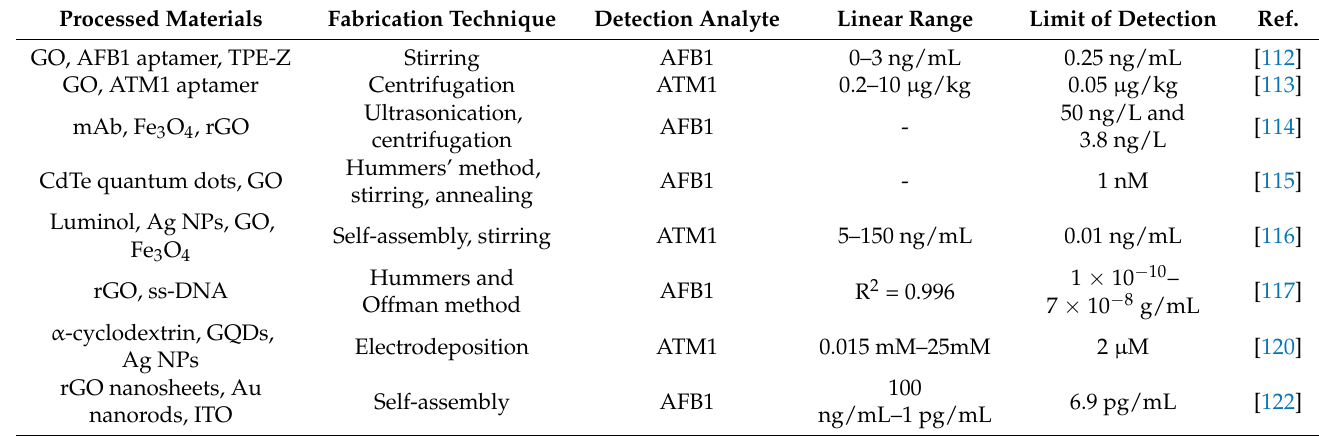
Table 4. Comparative study of the performances of the graphene-based sensors for the detection of ATM1 and AFB1 compounds. Processed Materials Fabrication Technique Detection Analyte Limit of